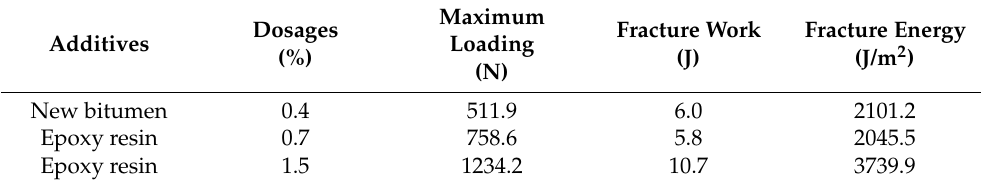
Figure 7. Displacement–load curve of − 10 ◦ C SCB test: ( a ) 0.4% bitumen; ( b ) 0.7% epoxy resin; ( c ) 1.5% epoxy resin. Table 7. Average fracture energy of − 10 ◦ C SCB